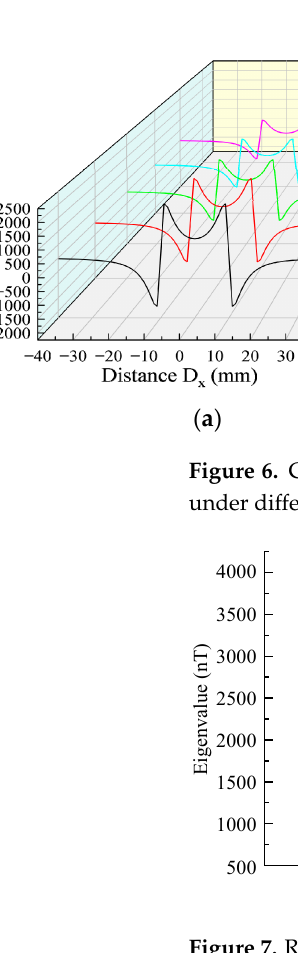
Figure 7. Relationship between stress and eigenvalue at the defect.